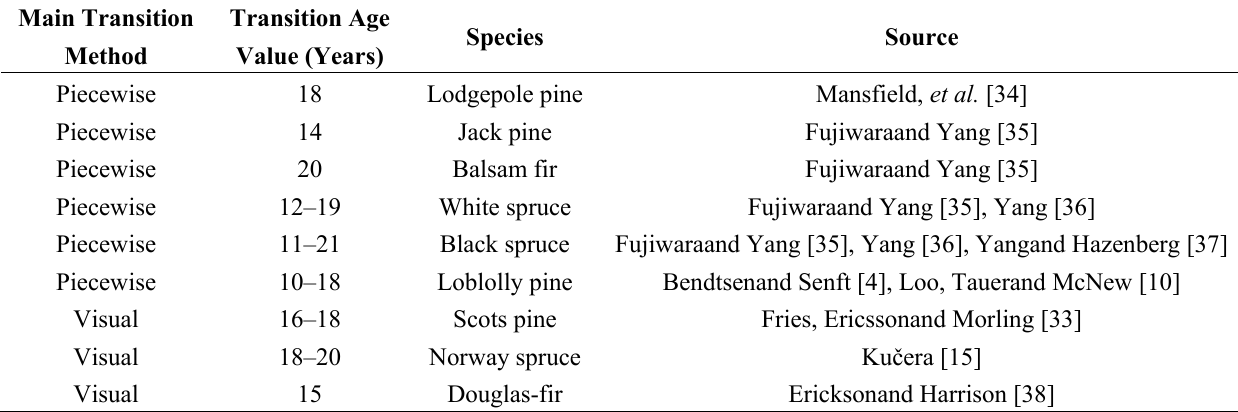
Table 2. Reported transition age (TA) with tracheid length